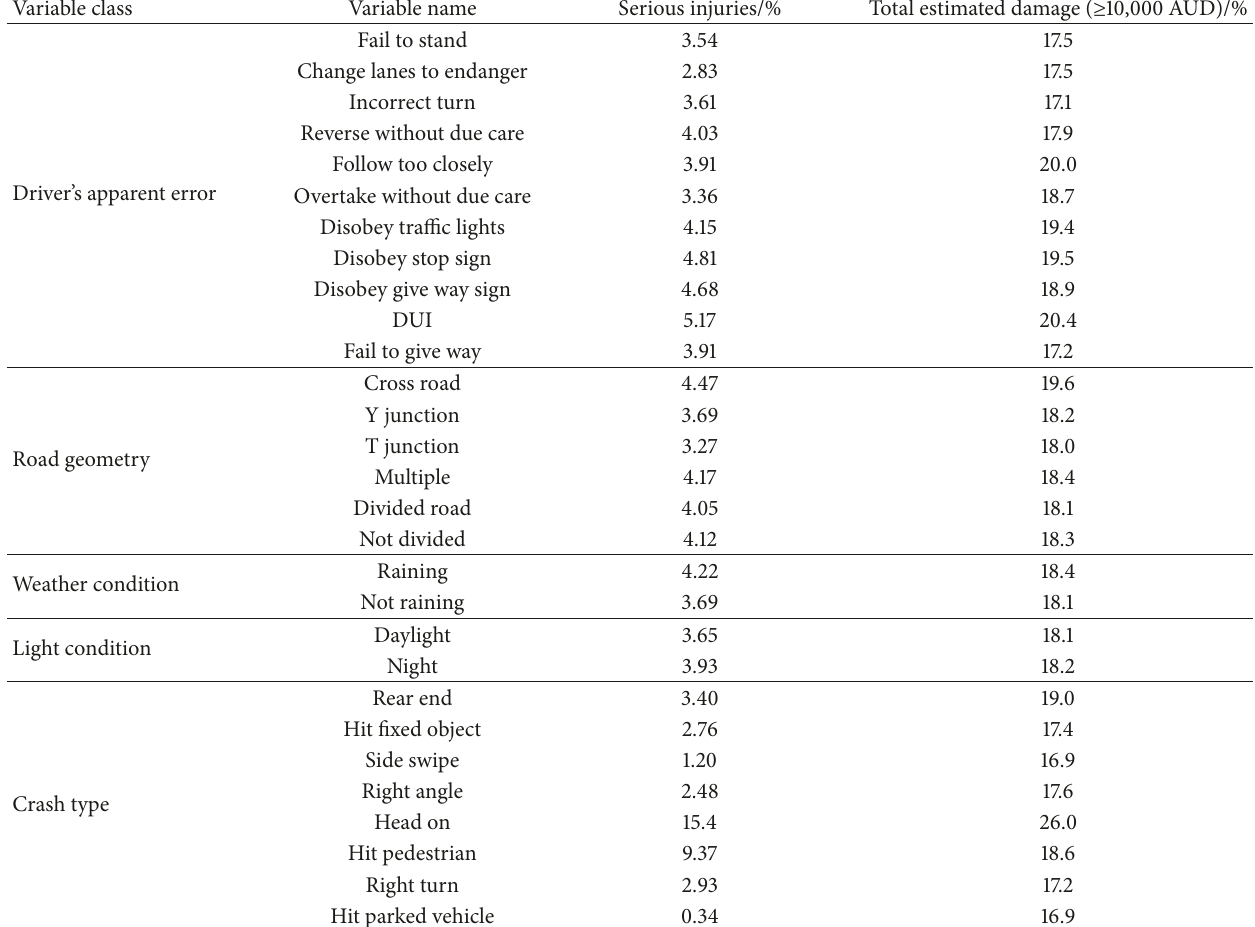
Table 4: Inference results for variables that are associated with “serious injuries” and “total estimated damage” in serious traffic